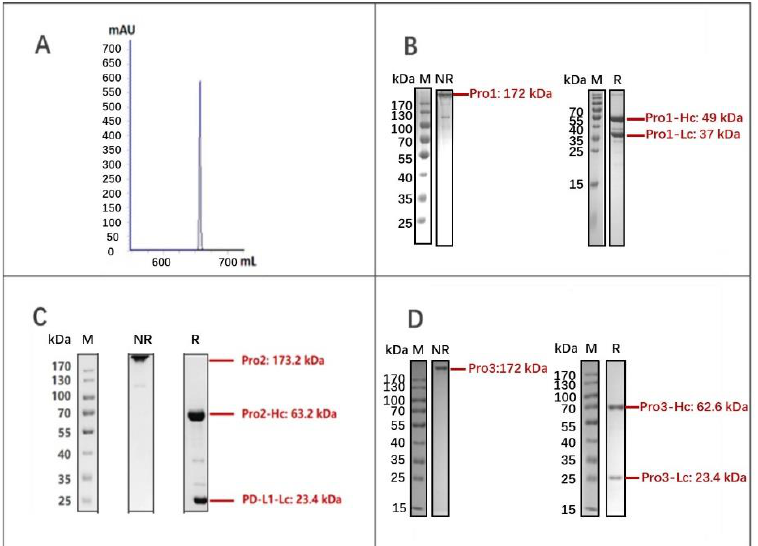
Figure 3. Expression and purification of dual-targeting fusion proteins. ( A ) Elution curve of Pro1 after MabSelect SURE purification; ( B ) SDS-PAGE analysis of Pro1 after affinity purification; ( C ) SDS-PAGE analysis of Pro2; ( D ) SDS-PAGE analysis of Pro3. (M: marker; NR: non-reduced samples; R: reduced samples).